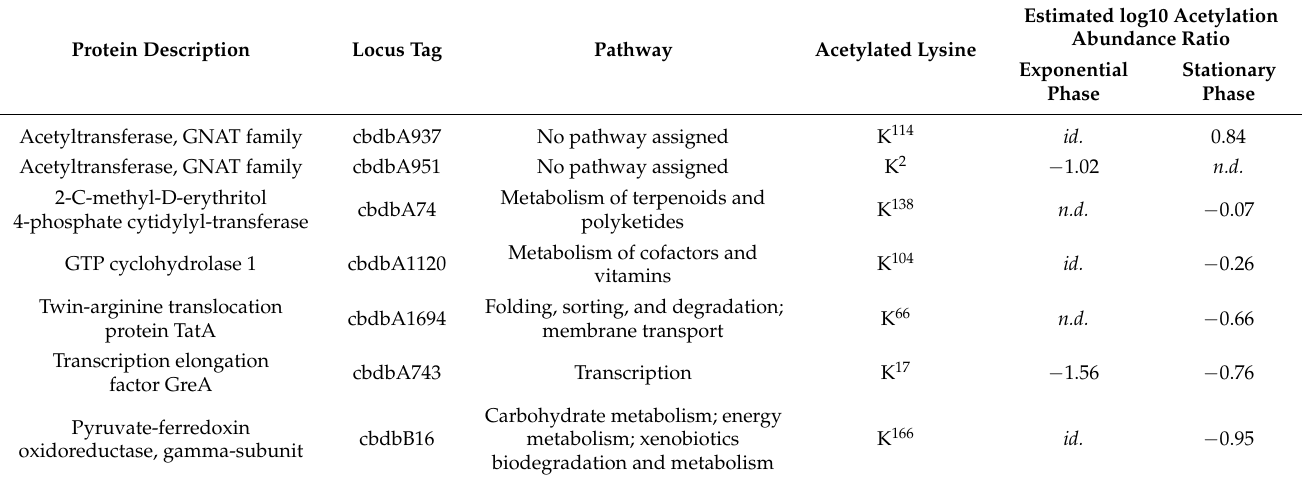
Table 1. Highly acetylated proteins (i.e., estimated log10 acetylation abundance ratio ≥ − 1.1 a